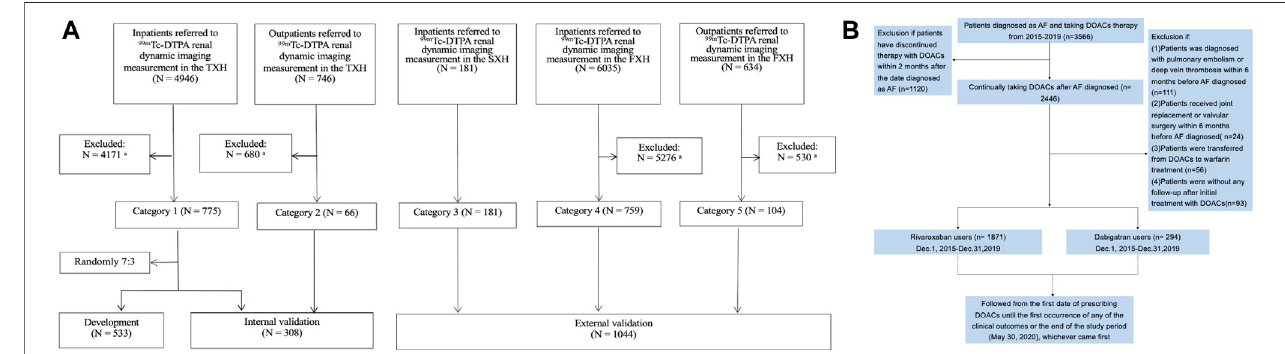
FIGURE1| Flowchartsofpresentstudyshowing: (A) developmentandvalidationofthenewequationpooledcreatininedatabase; (B) enrollment ofAFPatients in our study. (A) : Data from TXH and FXH were collected by using the database systems of both hospitals according to the same inclusion and exclusion criteria for screening populations, and the part from SXH was strictly extracted following the inclusion criteria in our research. 99m Tc-DTPA, 99m Tc-diethylene triamine pentaacetic acid; GFR, glomerular fi ltration rate; mGFR, measured GFR; TXH, the Third Xiangya Hospital of Central South University; SXH, the Second Xiangya Hospital of CentralSouth University; FXH,the First Af fi liated Hospital ofXinjiangMedicalUniversity. a Further detail ofpatientsexcluded according totheexclusion criteria areshown in Supplementary Table S1 . (B) : A total of 2,165 patients with nonvalvular AF was included. AF, atrial fi brillation; DOACs, direct oral anticoagulants.